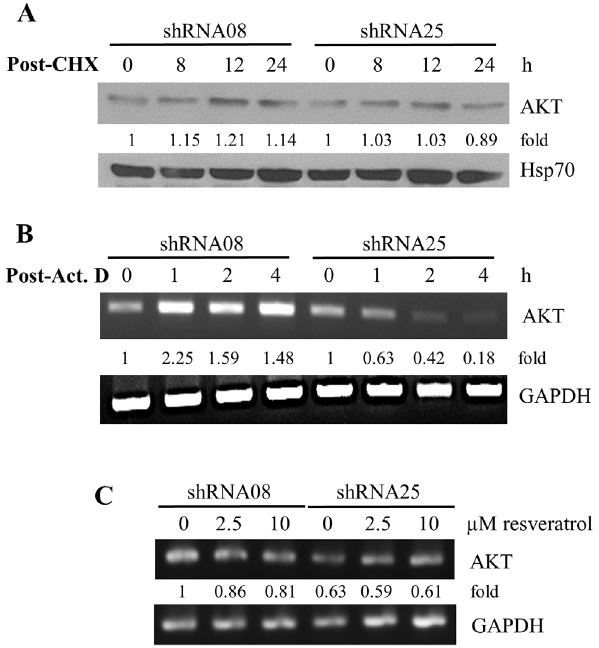
Figure 4. Analysis of stability of AKT protein and mRNA in relation to knockdown status of NQO2. ( A ) Turnover/degradation of AKT in shRNA08 or shRNA25 cells. Cells were treated with 30 m g/ml CHX to inhibit new protein synthesis for the times indicated. Changes in AKT was analyzed by western blot analysis, with Hsp70 expression used as loading control. AKT expression was quantified by densitometry analysis and the expression was presented as fold relative to time zero. ( B ) Effect of knockdown NQO2 on AKT mRNA stability. Both shRNA08 and shRNA25 cells were treated with transcription inhibitor actinomycin D (5 m g/ml). Cells were harvested at 0, 1, 2 and 4 h after